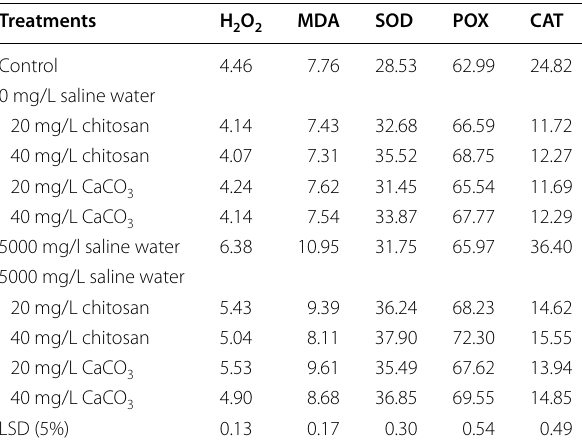
Table 6 Effect of chitosan and calcium carbonate (0, 20 and enzymes (SOD, POX and CAT U/min/g FW) activities of wheat plant growing under different salinity levels (0, 5000 mg/L)